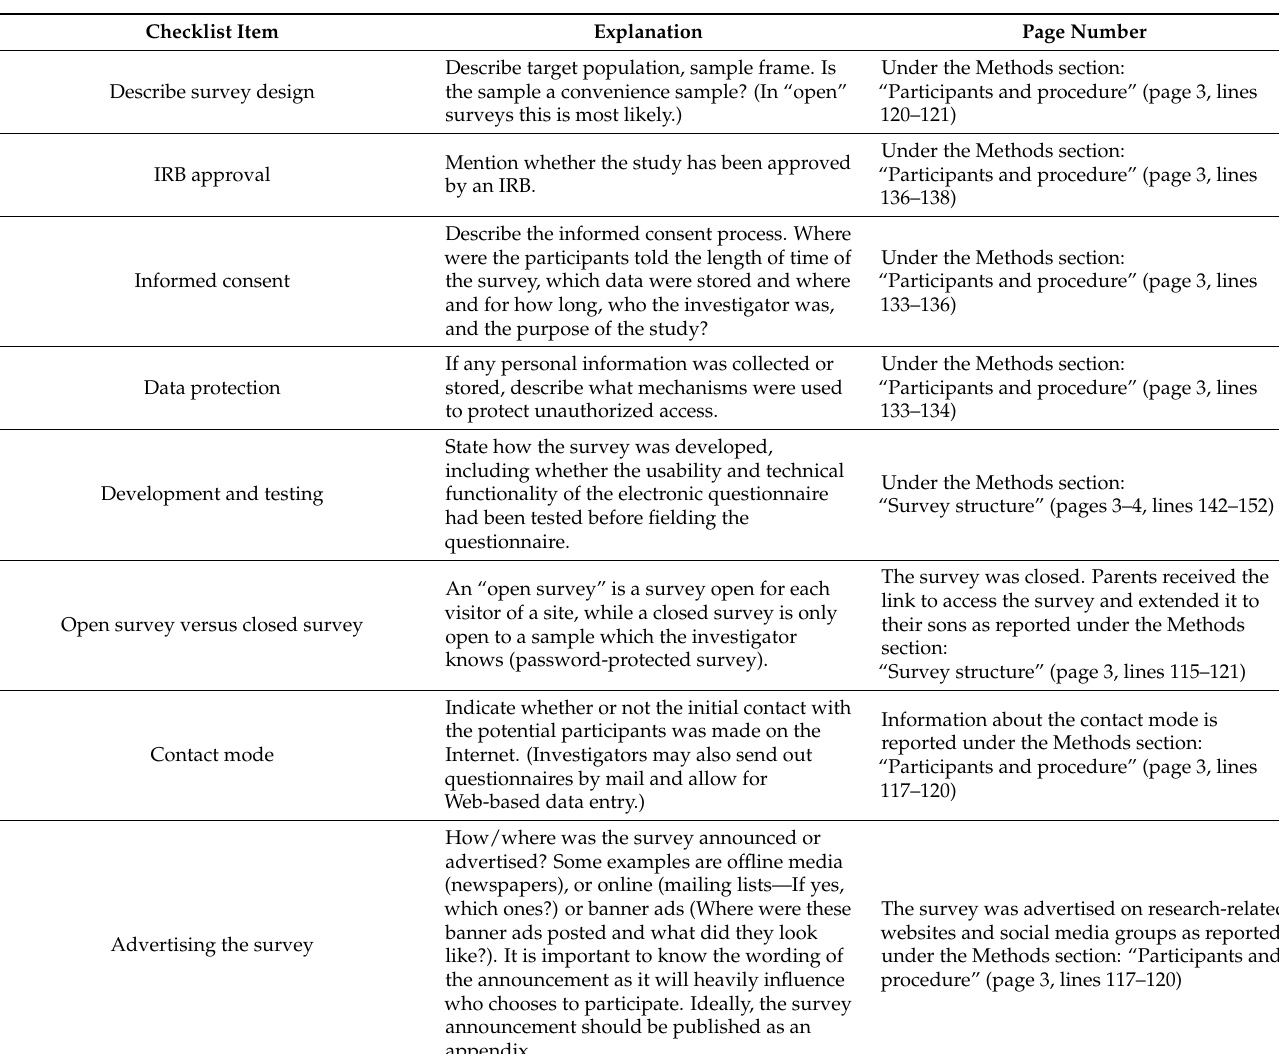
Table A1. Checklist for Reporting Results of Internet E-Surveys